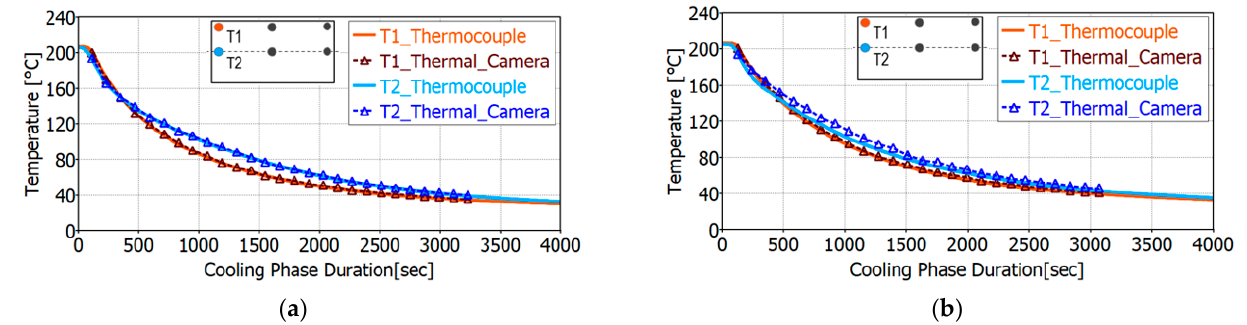
Figure 4. Comparison of experimental temperature from thermocouples and thermal camera for ( a ) Test 1 and ( b ) Test 3.